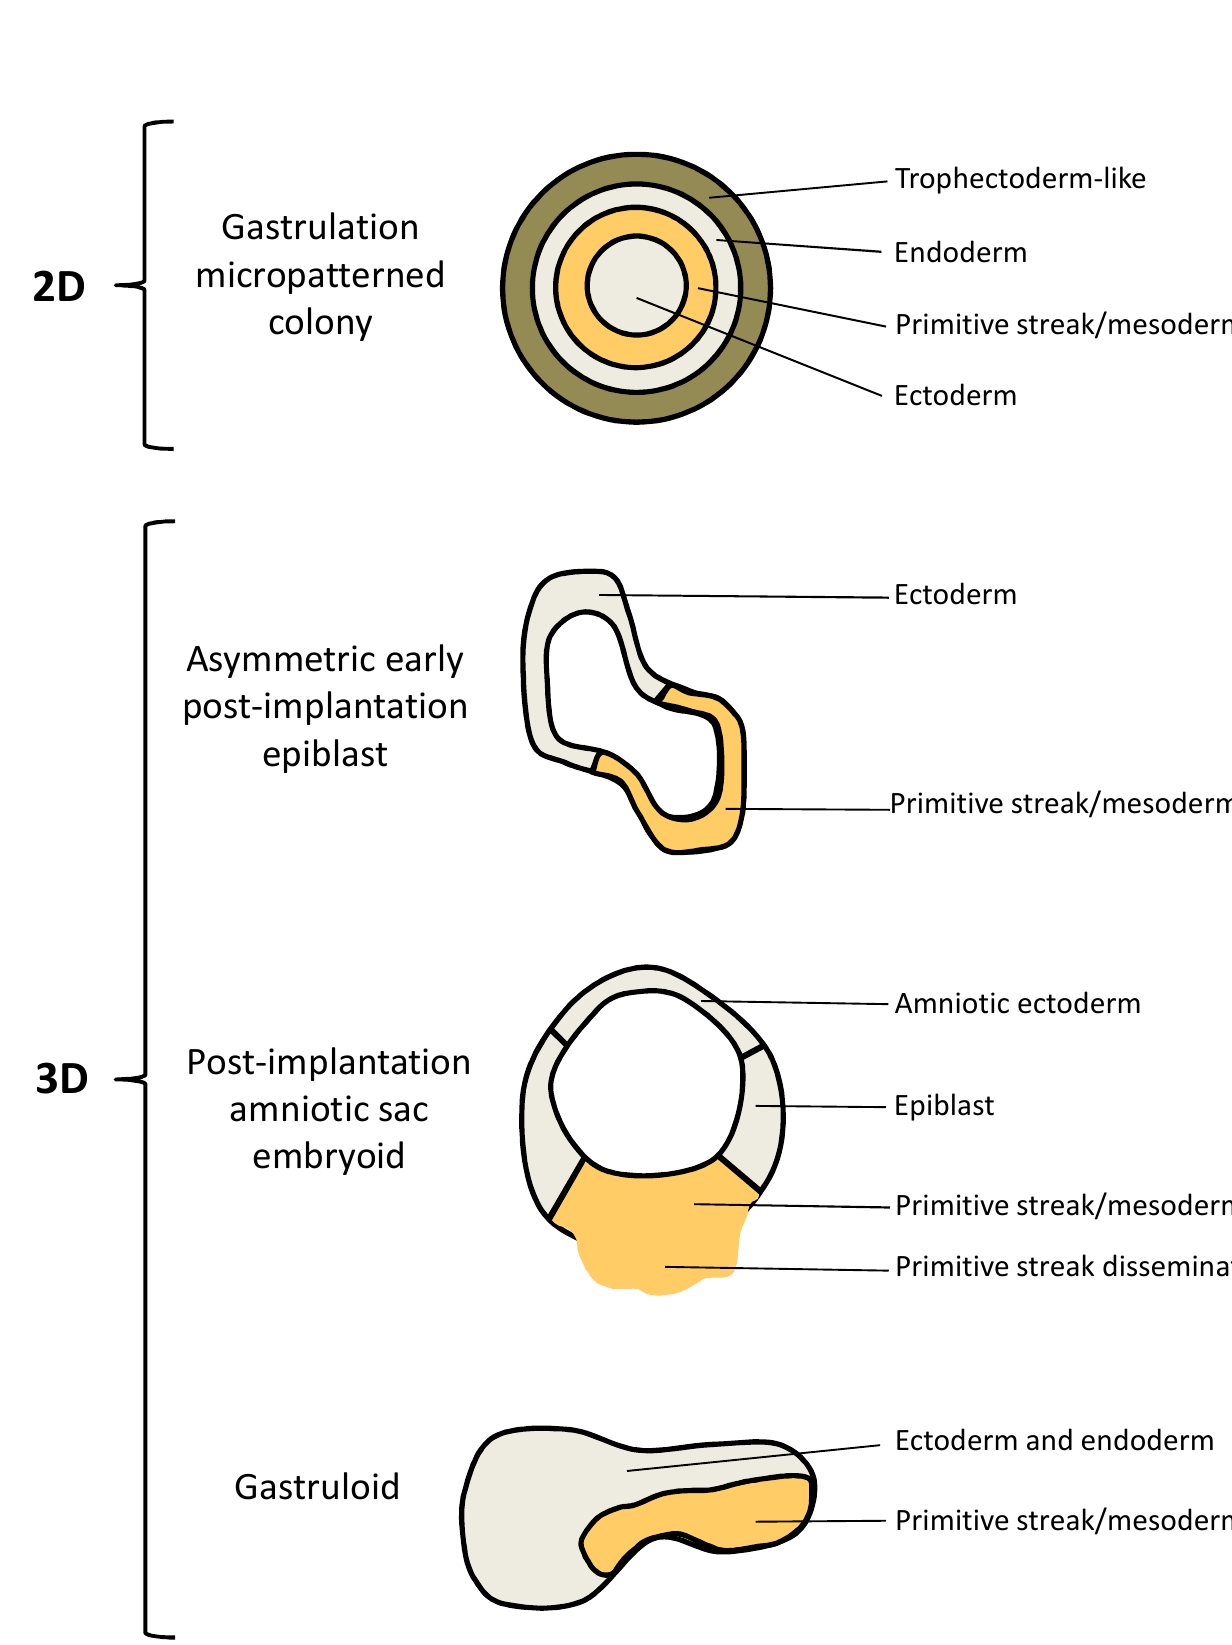
Figure 1. Schematic representation of the human embryo models. For detailed description see the text and Table